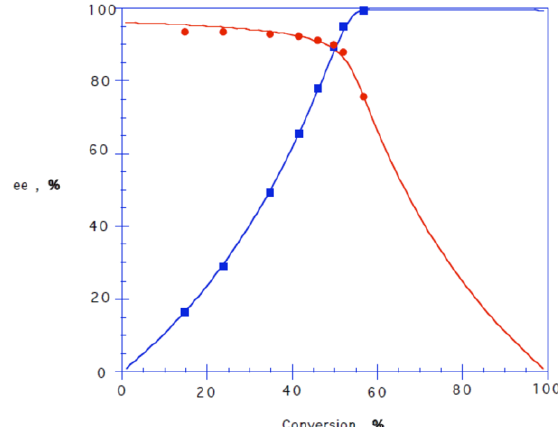
Figure 2. Graphical representation of kinetic resolution of chlorohydrin 4 with CALB in dry acetonitrile with vinyl butanoate as acyl donor. ee S (blue squares, ee of the substrate ( R )- 4 ) and ee P (red circles, ee of the ester product ( S )- 5 ) in percent plotted against conversion in percent. The blue and the red curves are generated from the experimental values of ee S and ee P , respectively. The E -value was calculated to 52. E -values are calculated using E&K Calculator 2.1b0 PPC [16].